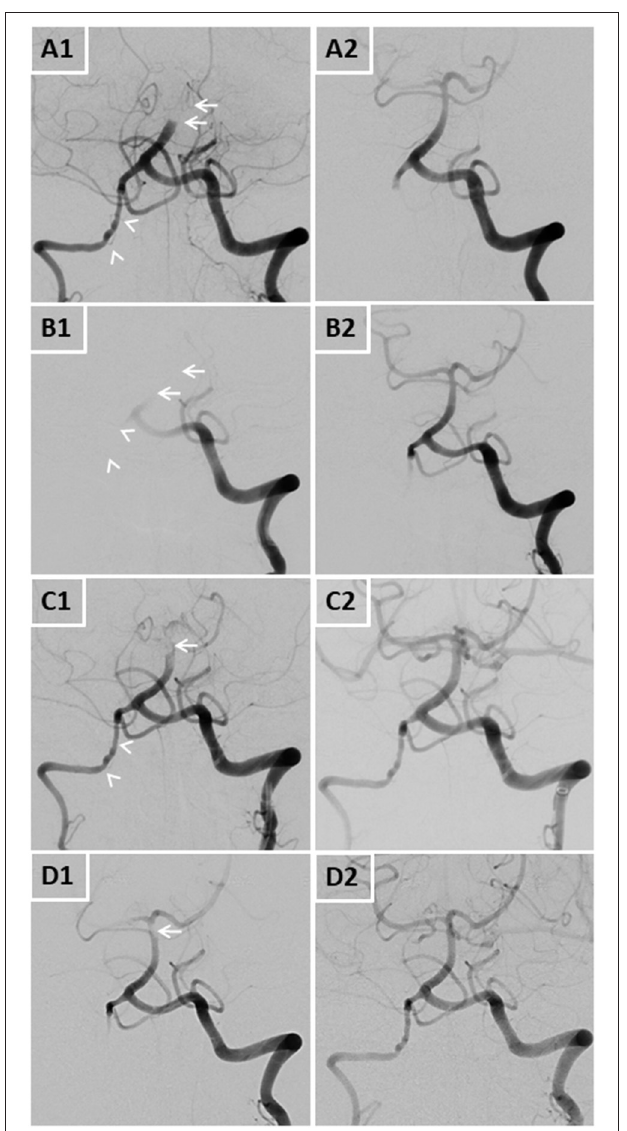
FIGURE 1 | DSA images of all four basilar artery occlusions pre- (A1,B1,C1,D1) and post-interventionally (A2,B2,C2,D2) . Arrows display arterial occlusions and/or thrombi, arrowheads display the dysplastic right vertebral artery.